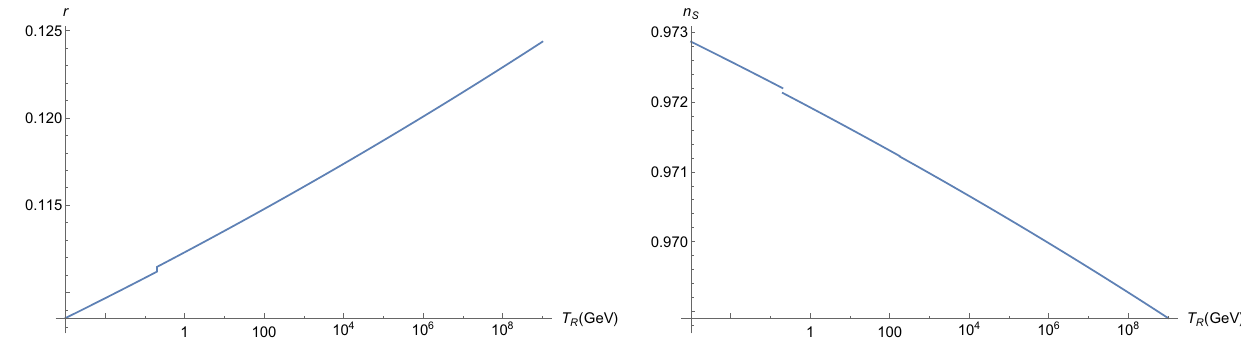
Fig. 2 Phase portrait in the plane (ϕ/ M pl , ˙ ϕ/ M 2 function of the time t × M pl (right) for the same orbits represented in the phase portrait